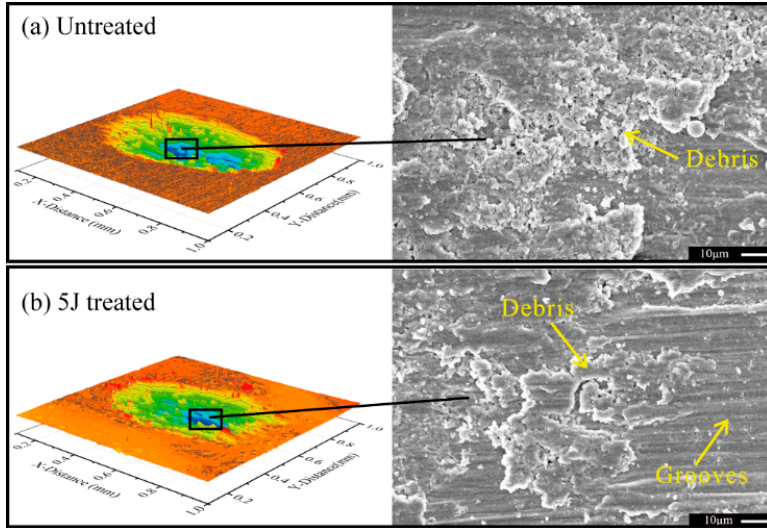
Figure 8. Micrographs of worn scars. ( a ) Untreated; ( b ) 5 J treated; ( c ) 7 J treated.